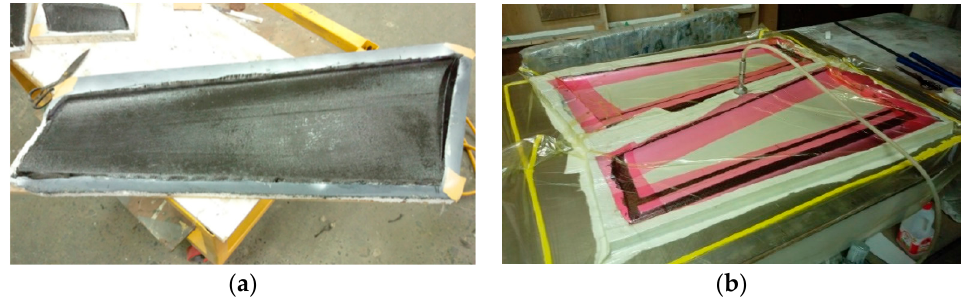
Figure 11. ( a ) Hand lay-up and open molding method and ( b ) vacuum bag molding method.